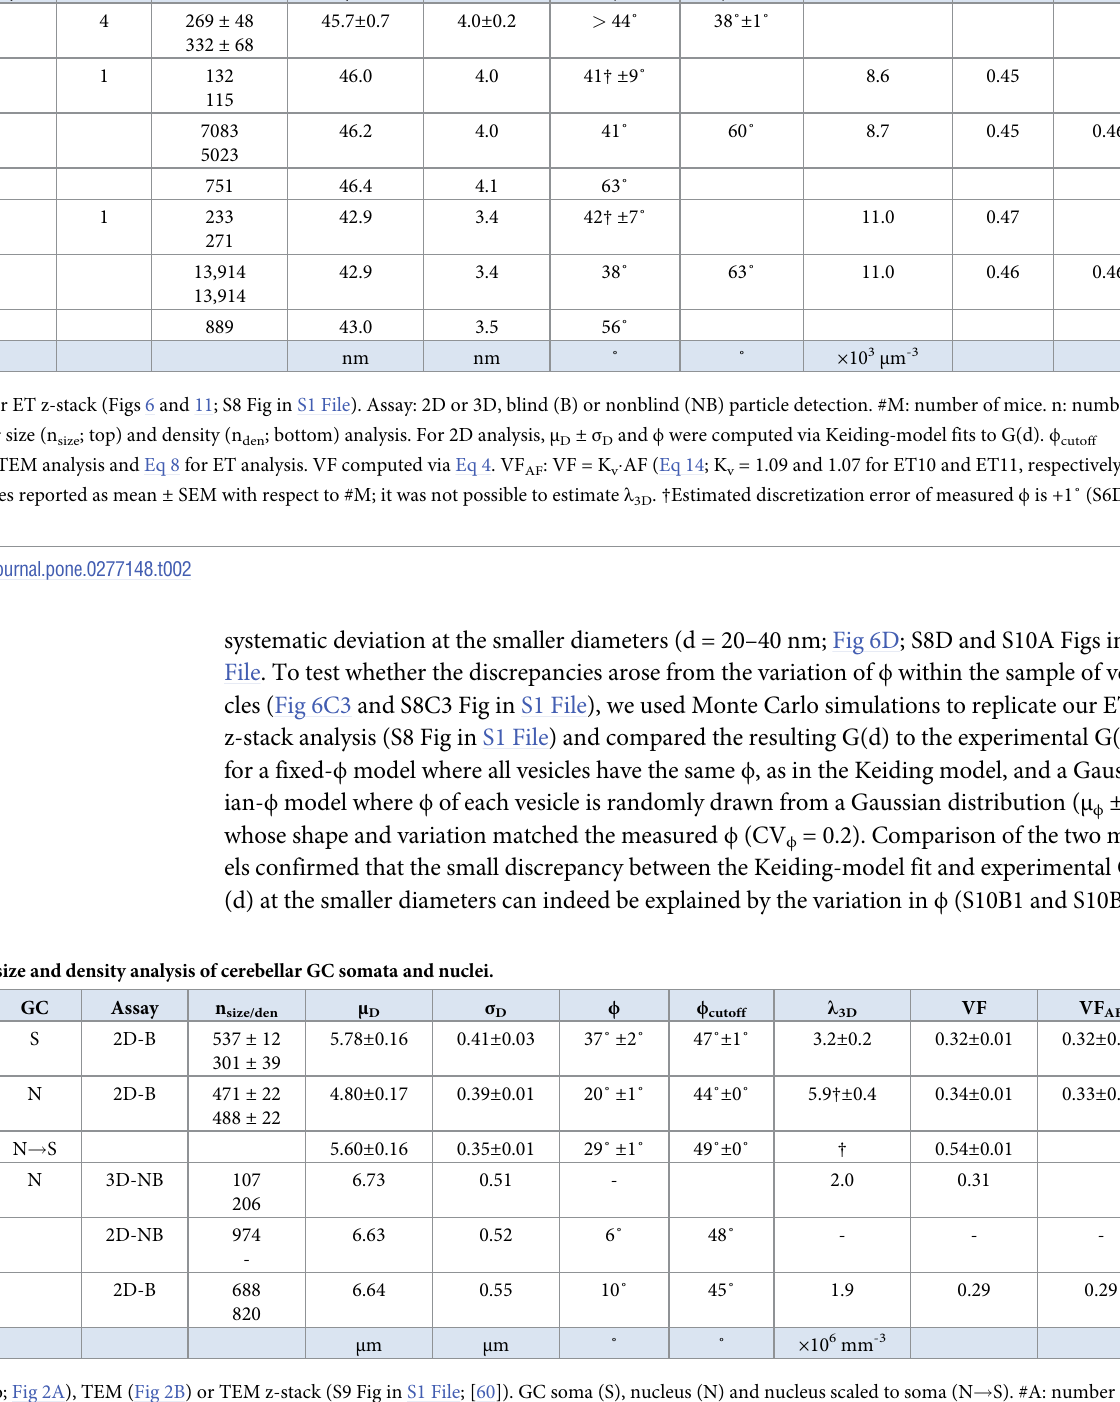
Table 2. Summary of size and density analysis of cerebellar MFT vesicles. Image